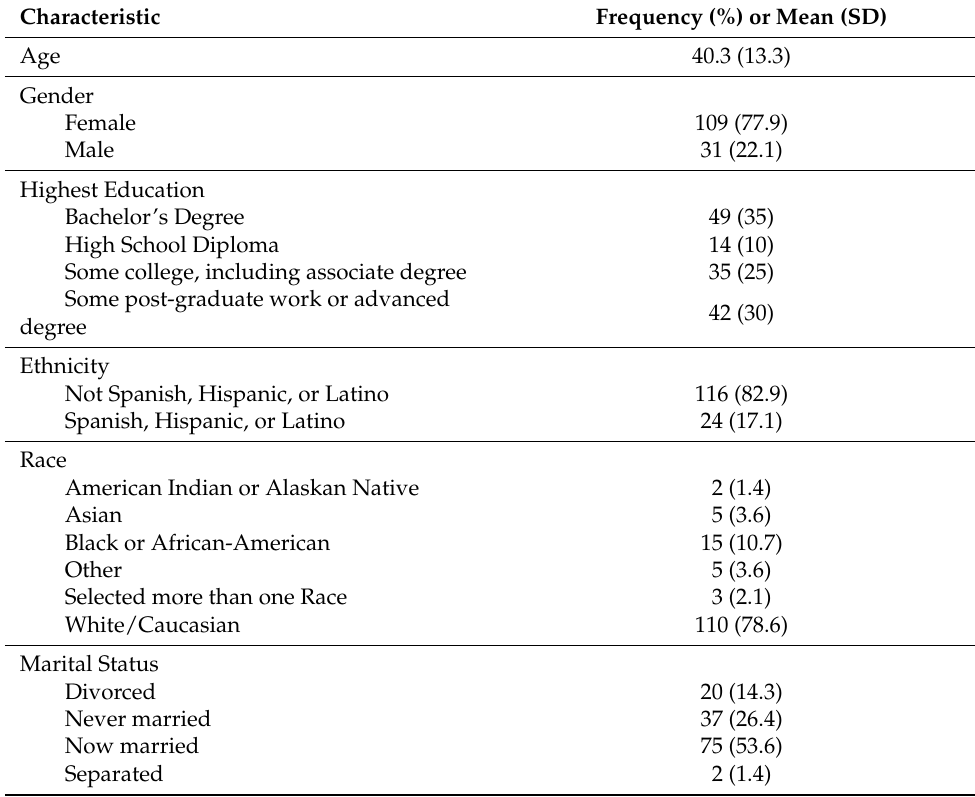
Table 1. Health Professionals’ Demographic Information ( N = 140).